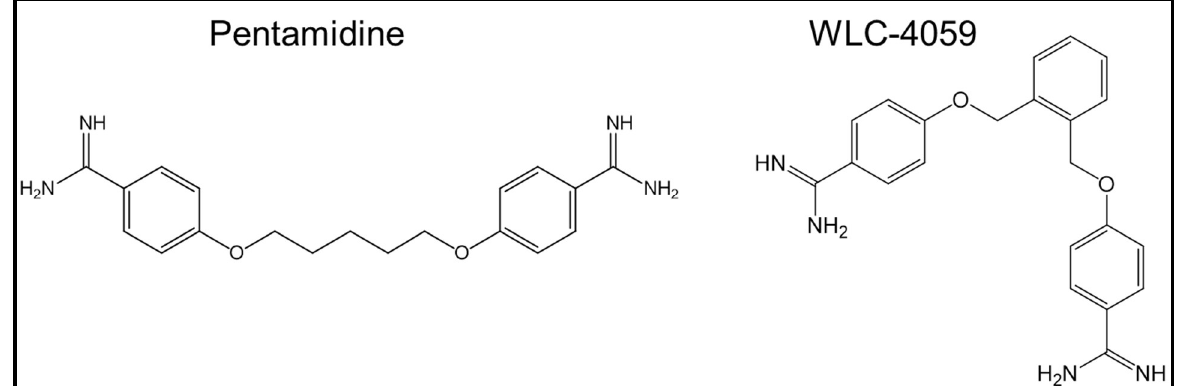
Figure 1. Chemical structures of pentamidine and its newly synthesized analog (WLC-4059). Pentamidine is also used for the treatment of Pneumocystis carinii pneumonia (PCP), leishmaniasis, yeast infections caused by Candida albicans , and Acanthamoeba infections in immunocompromised patients and as a prophylactic antibiotic for children undergoing treatment for leukemia [25].